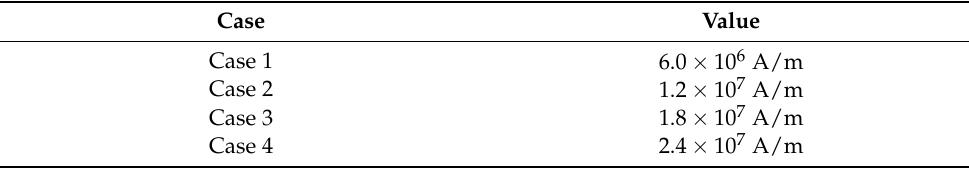
Table 3. Magnetization applied in this